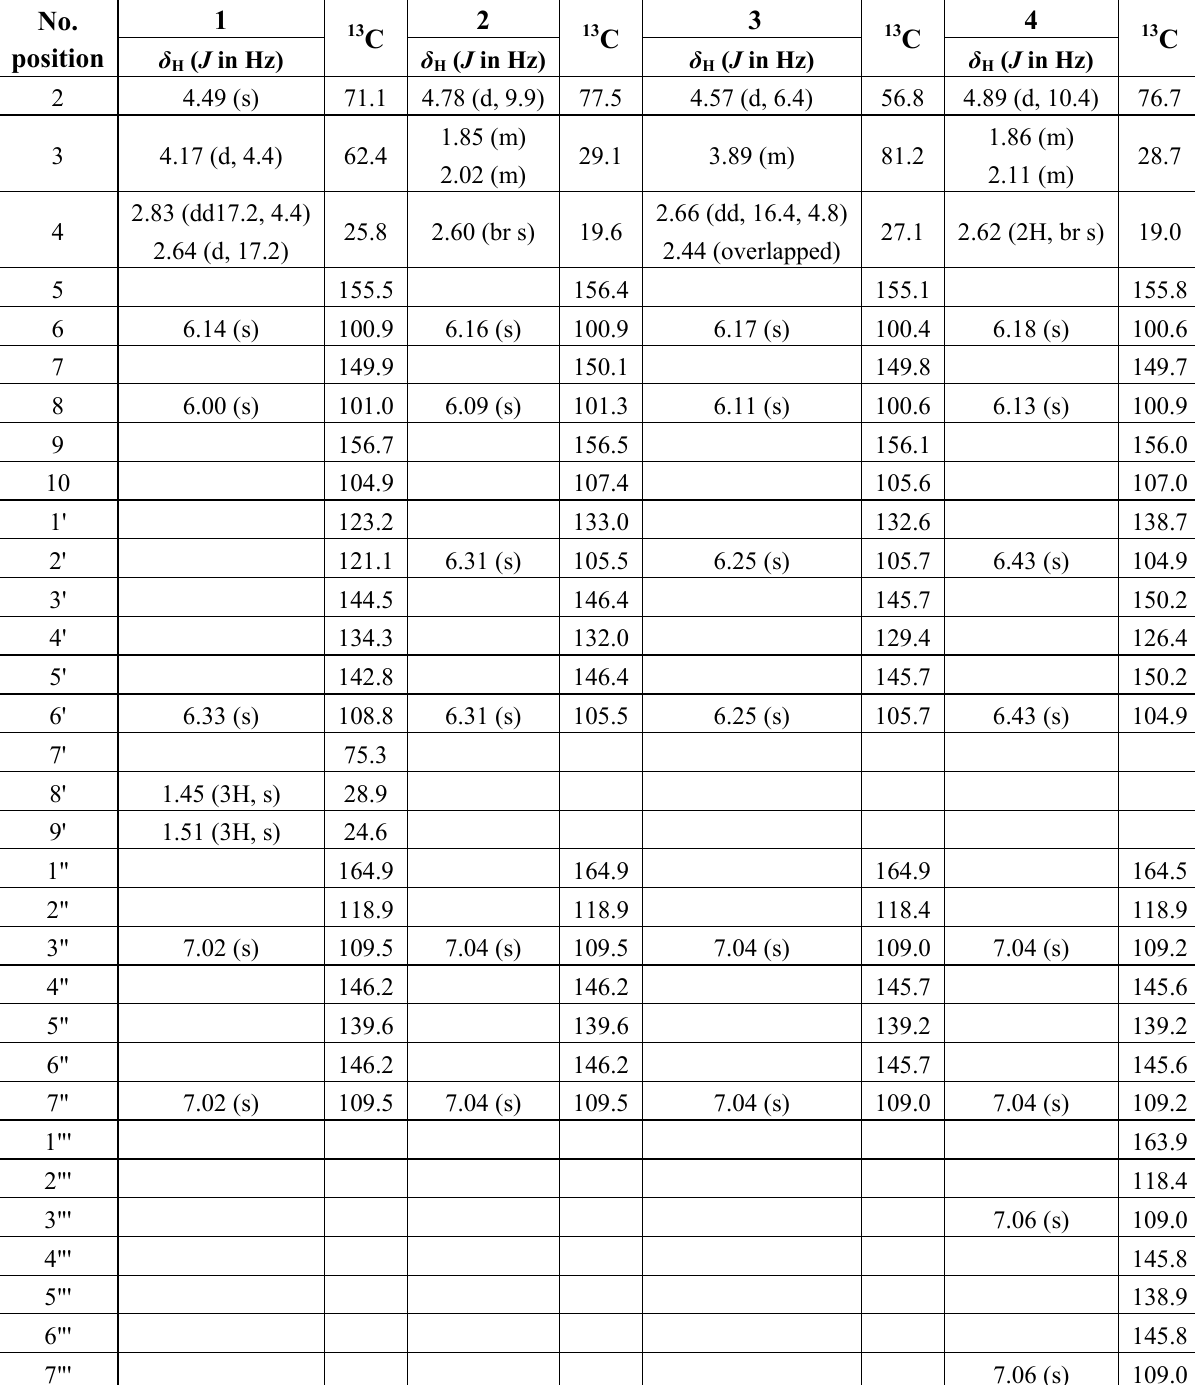
Table 2. 1 H- (400 MHz) and 13 C-NMR (100 MHz) data of compounds 1 – 4 in DMSO- d